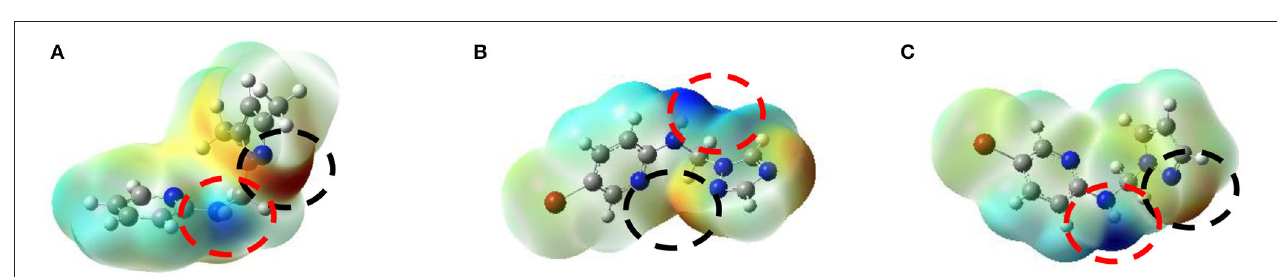
FIGURE 9 | MEP surfaces for the three best anti- Fusarium candidates 2 (A) , 4 (B) , and 5 (C) , where the negative regions (black circle) are related to electrophilic reactivity, whereas the positive regions (red circle) are for nucleophilic reactivity.